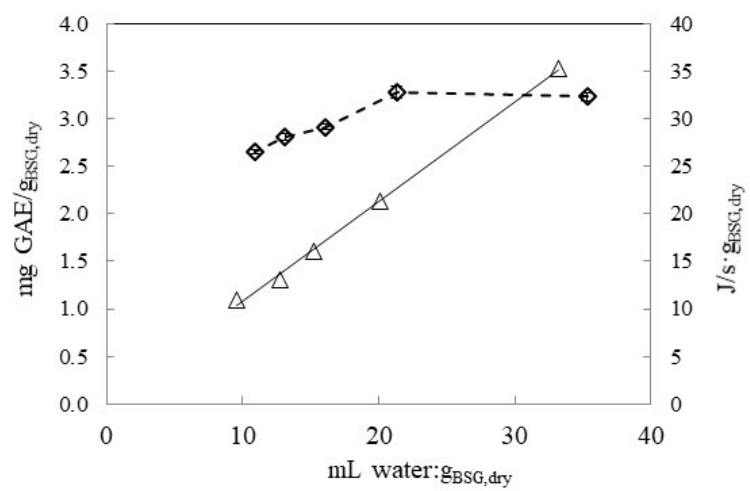
Figure 3. TPC water extraction yield, mg GAE/ g BSG,dry ( ◇ ) and power density, △ , (PD, J/s·g) as a function of solvent:mass ratio after 1800 s of UAE at 47 °C. Continuous line represents the linear fitting of PD (PD = 1.0547 (mL:g) + 0.1905, R 2 = 0.9983).